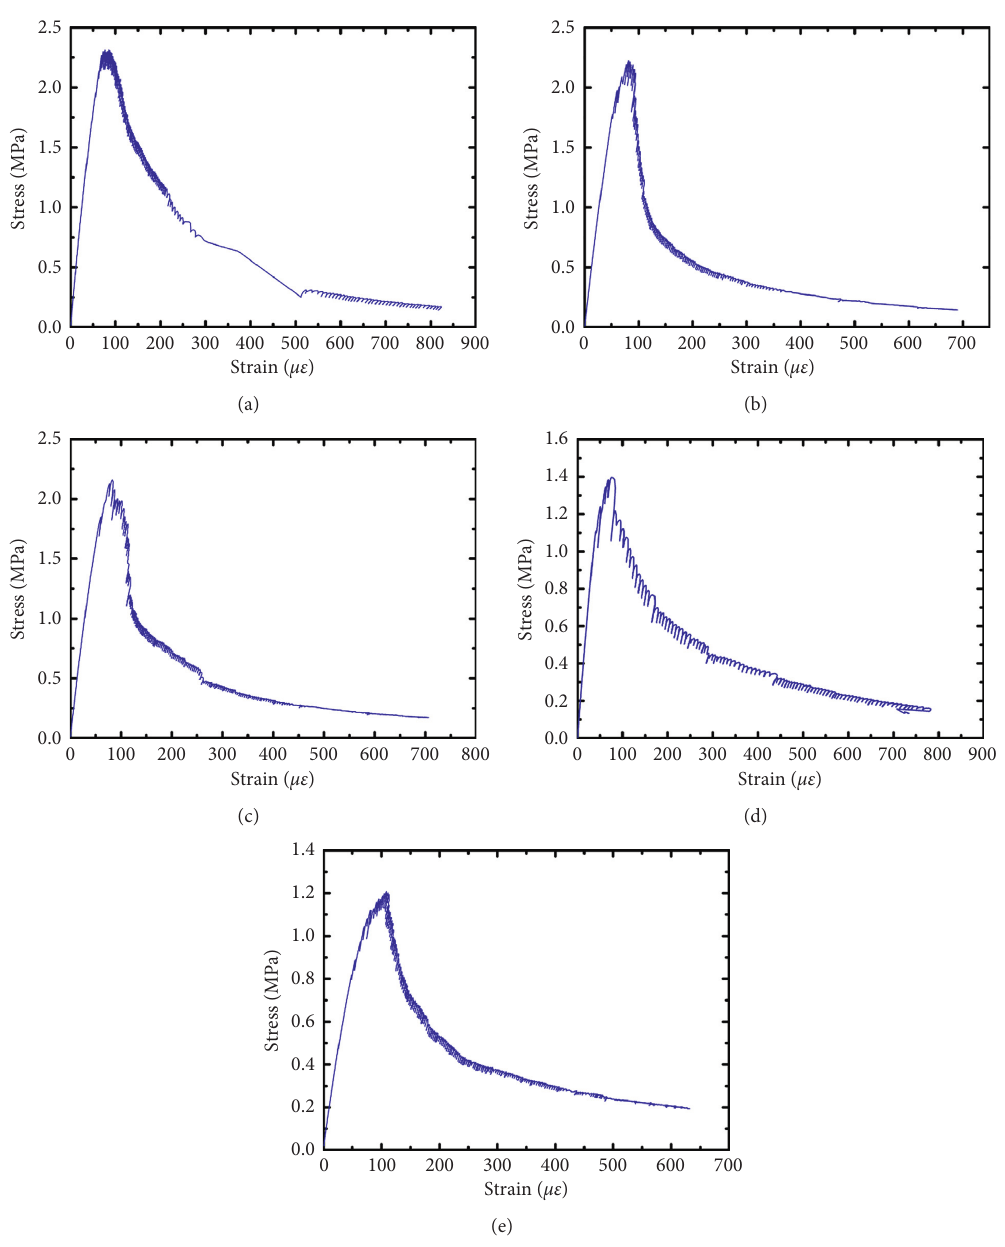
Figure 9: Stress-strain curves of RAPC under uniaxial tension. (a) RAPC0; (b) RAPC25; (c) RAPC50; (d) RAPC75; (e)